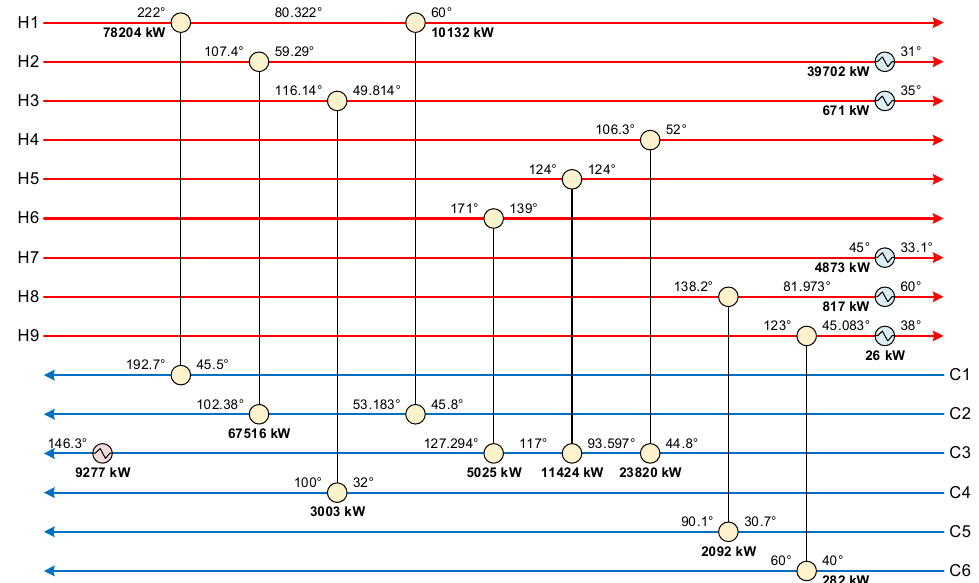
increase. Therefore, such a retrofit project cannot be implemented. The process engineers then suggested seeking an alternative solution that does not require additional heat trans- Figure 4. Existing HEN of the EG process (updated). Figure 4. Existing HEN of the EG process (updated). fer area for match H1–C1. Solving the HEN model considering all feasible matches in six stages yields the re- sults in Figure 5. The minimum utility requirements are determined to be 0 kW of 180 °C steam and 36,812 kW of cooling water. This can be achieved in the minimum number of units of 15 (10 exchangers, no heater and five coolers). The main feature of this optimized HEN is that instead of using steam, the outlet recycle gas (H1) is used to heat the EO solution (C3). Compared with the base case in Figure 4, the steam demand decreases by 100%, while the cooling water demand decreases by 20%. The cost benefit associated with this steam saving is calculated to be 7.5 million USD/y, assuming steam costs 0.101 USD/kWh and the plant operates for 8000 h/y [26]. This solution was further evaluated for its feasibility. To achieve the theoretical re- duction in steam demand of 9277 kW, the HEN retrofit entails adding a new match (H1– C3) and modifying two existing ones for decreased temperature differences (H1–C1) and increased heat transfer (H2–C2). The total retrofit cost is estimated at 24.2 million USD by the process engineers. Dividing the total retrofit cost by the annual cost saving gives a payback period of 3.2 y. On the other hand, the decrease in the logarithmic mean temper- ature difference of match H1–C1 (from 32 to 13.3 °C) requires a three-times larger heat transfer area for the same heat duty. Although the design in Figure 5 does not pose a hazard to the EG process, the plant has no space to accommodate the required area